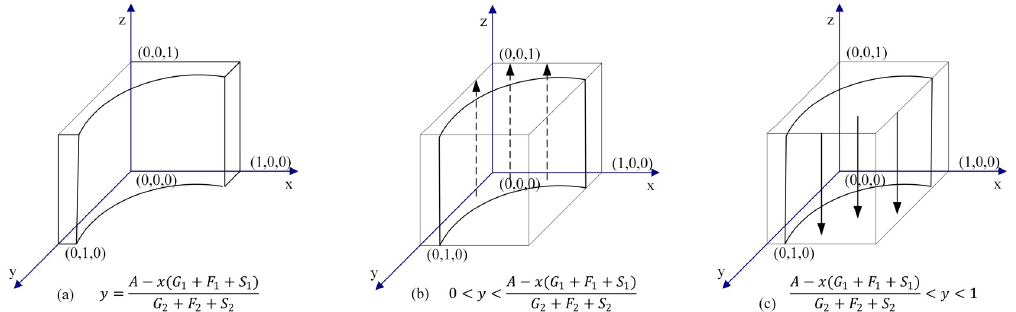
Fig 4. Dynamic evolution chart of TPIPs’